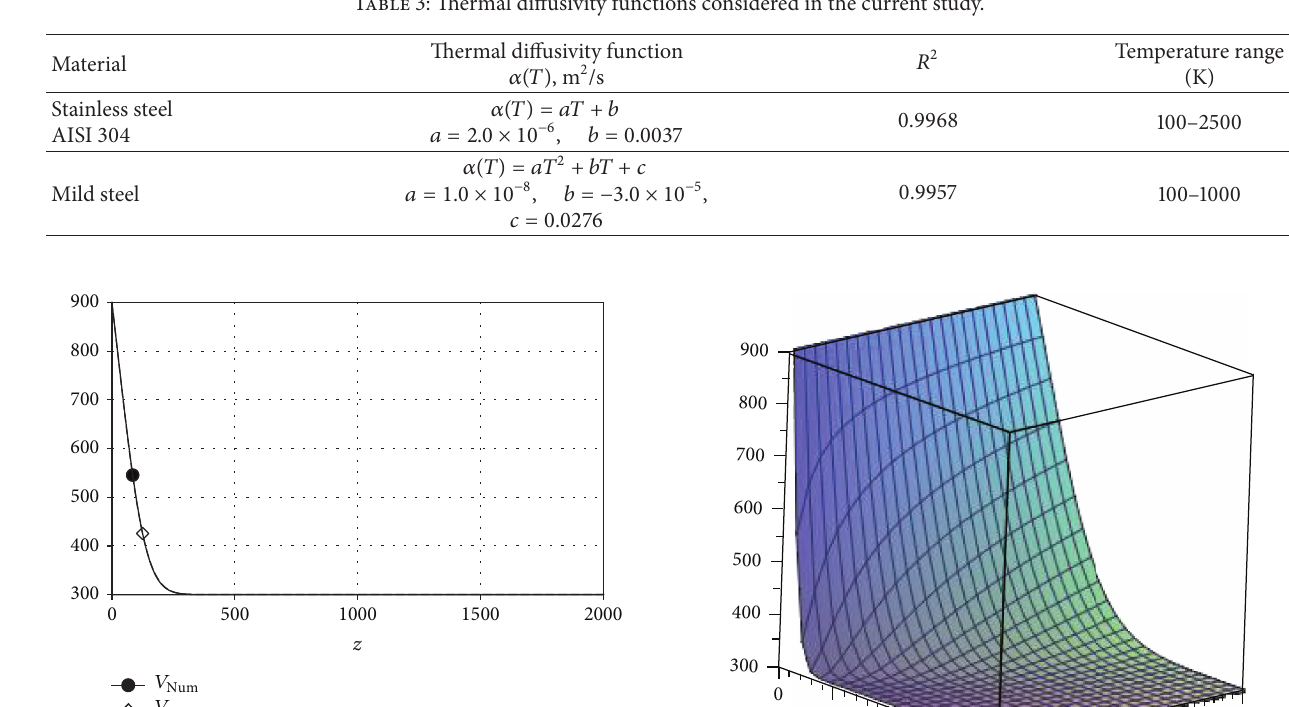
Table 3: Thermal diffusivity functions considered in the current study.